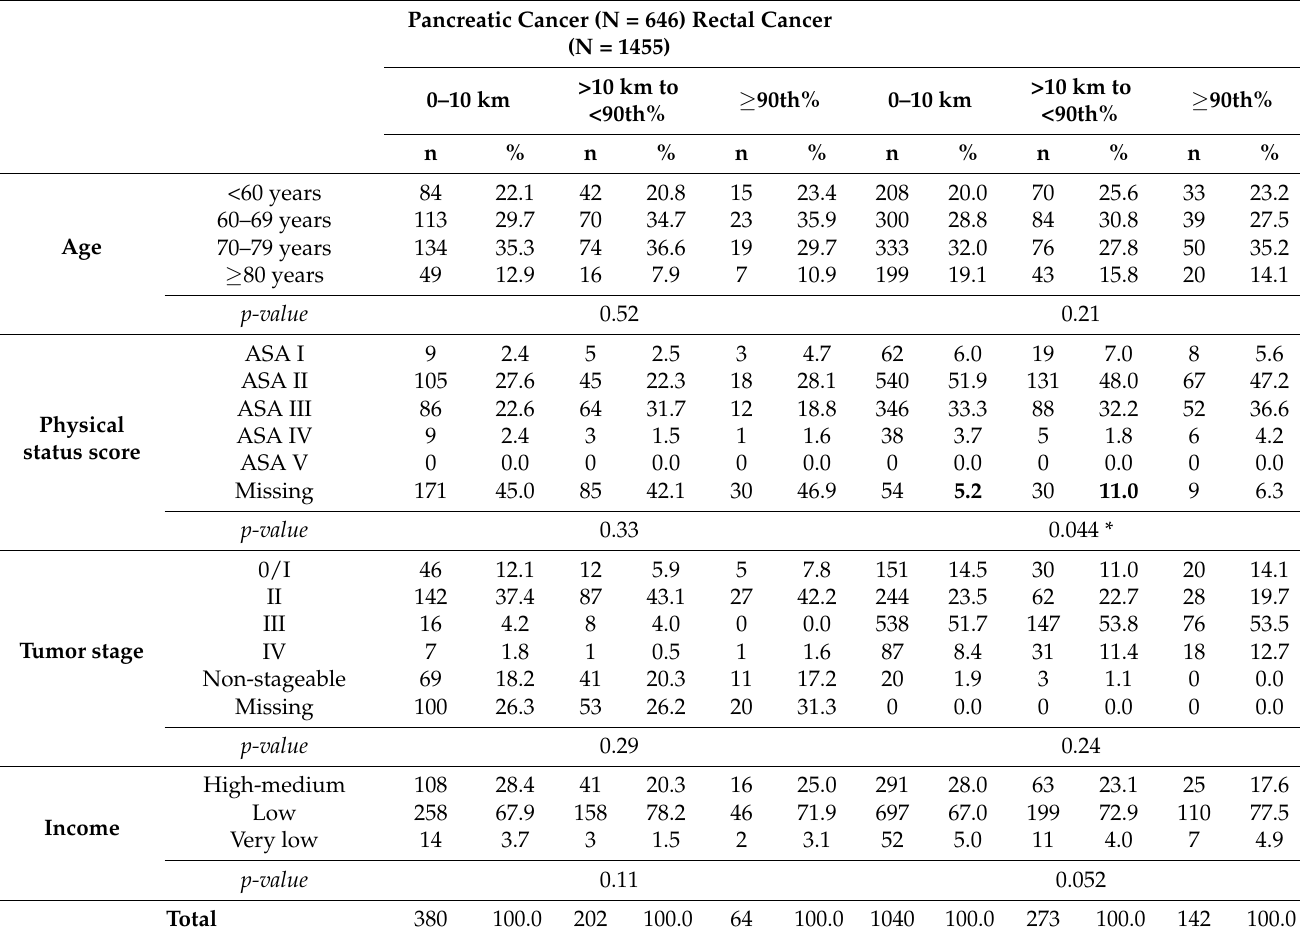
Table 2. Baseline characteristics according to distance between patients’ homes and treatment centers.